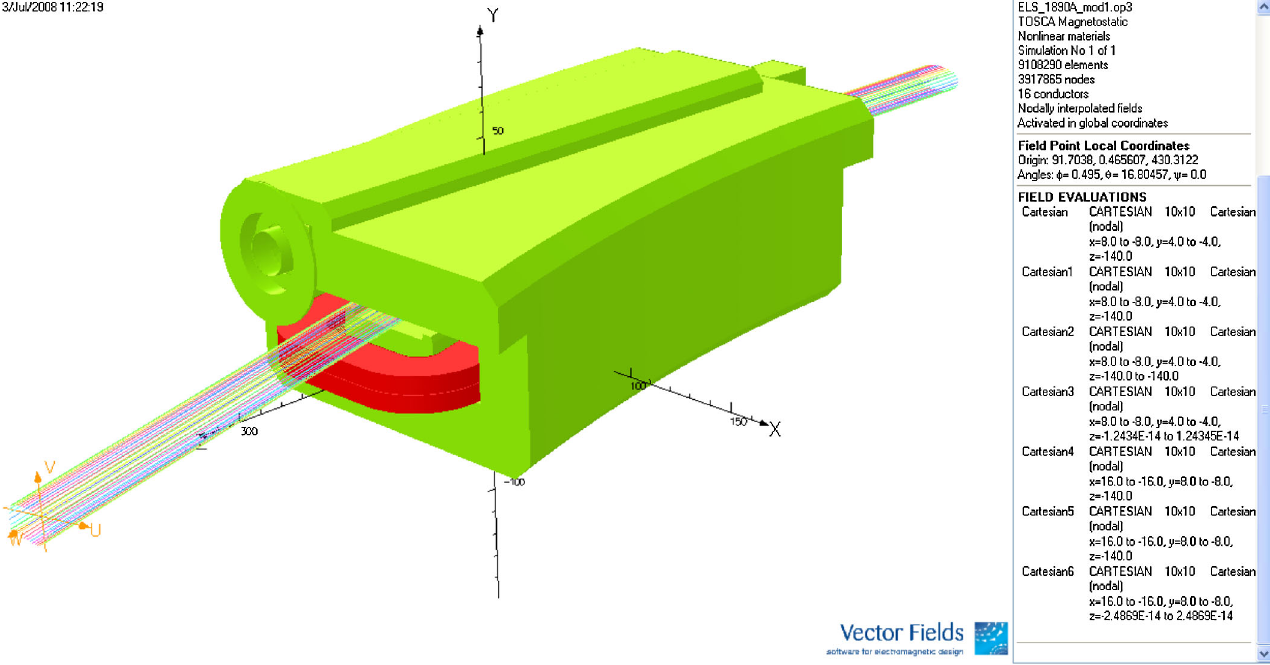
FIG. 19. (Color) Trajectories of a laminar beam without space charge through the